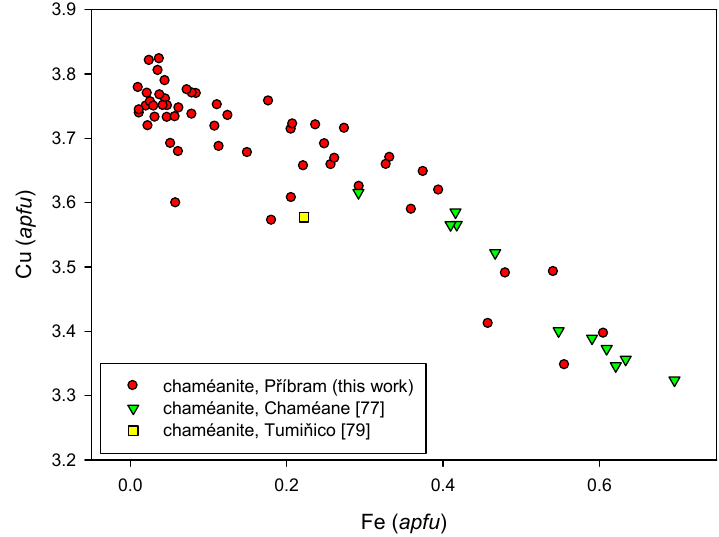
Figure 24. Fe vs. Cu ( apfu ) graph for chaméanite from P ř íbram and other localities.